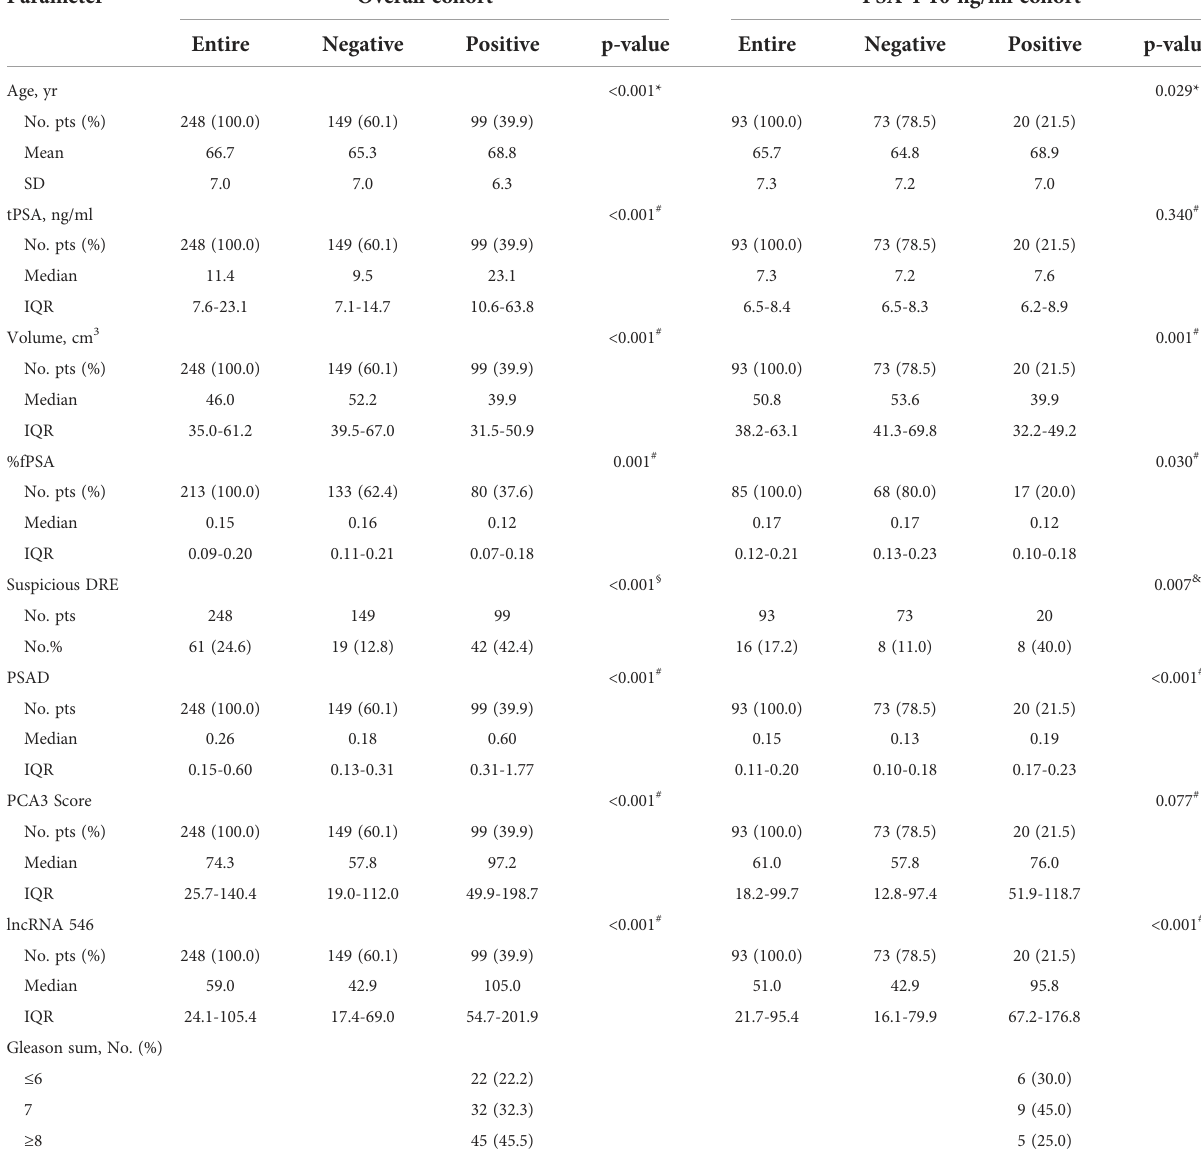
TABLE 1 Prostate cancer-related risk factors in the discovery cohort.